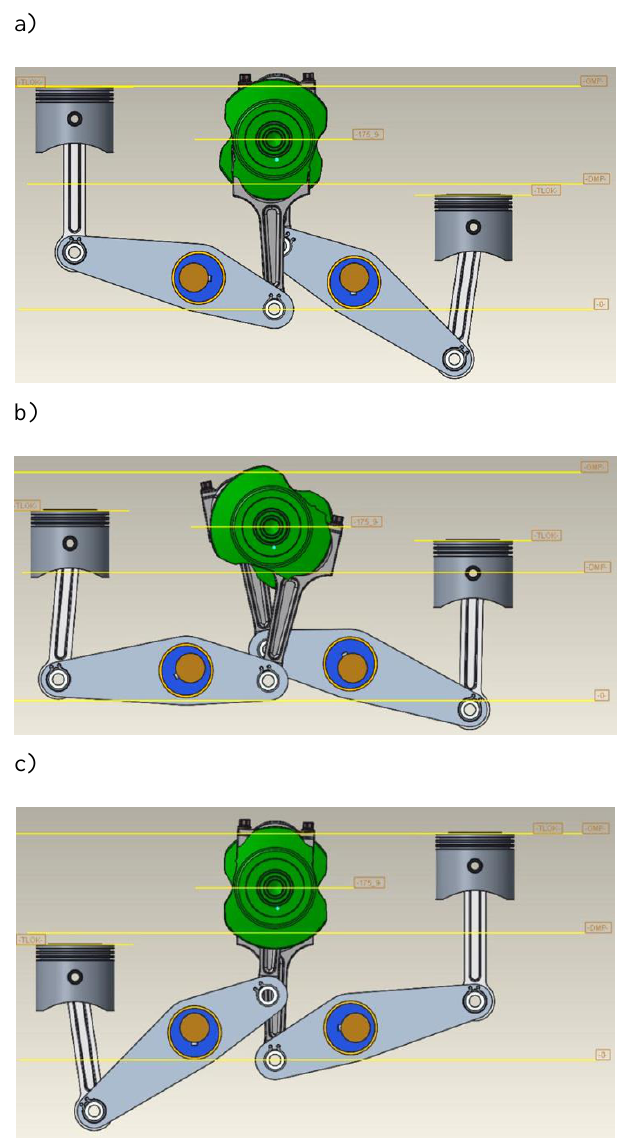
Fig. 7. New conception in various crankshaft angular positions: a) 0 CA deg, b) 120 CA deg, c) 180 CA